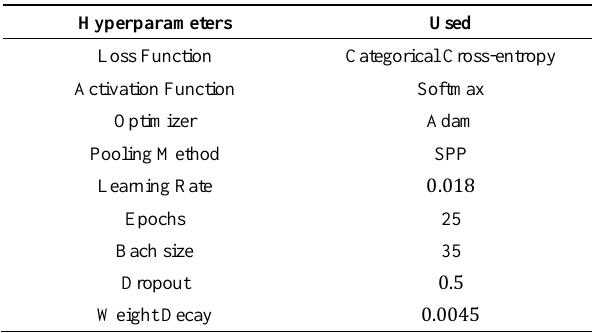
Table 2. Hyper parameters Used during